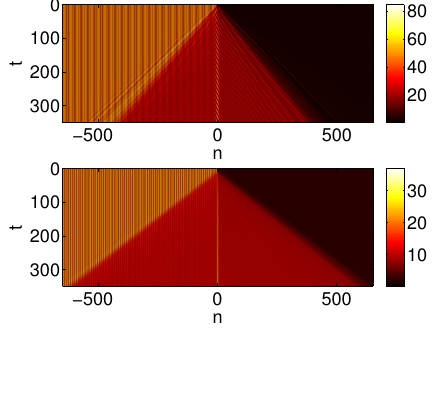
( t ) | 2 as a function of n and t . The top plot corresponds to Figure 7. The plots show | φ n parameters the same as in the right four plots in Figure 4. The bottom plot corresponds to parameters the same as in the left four plots in Figure